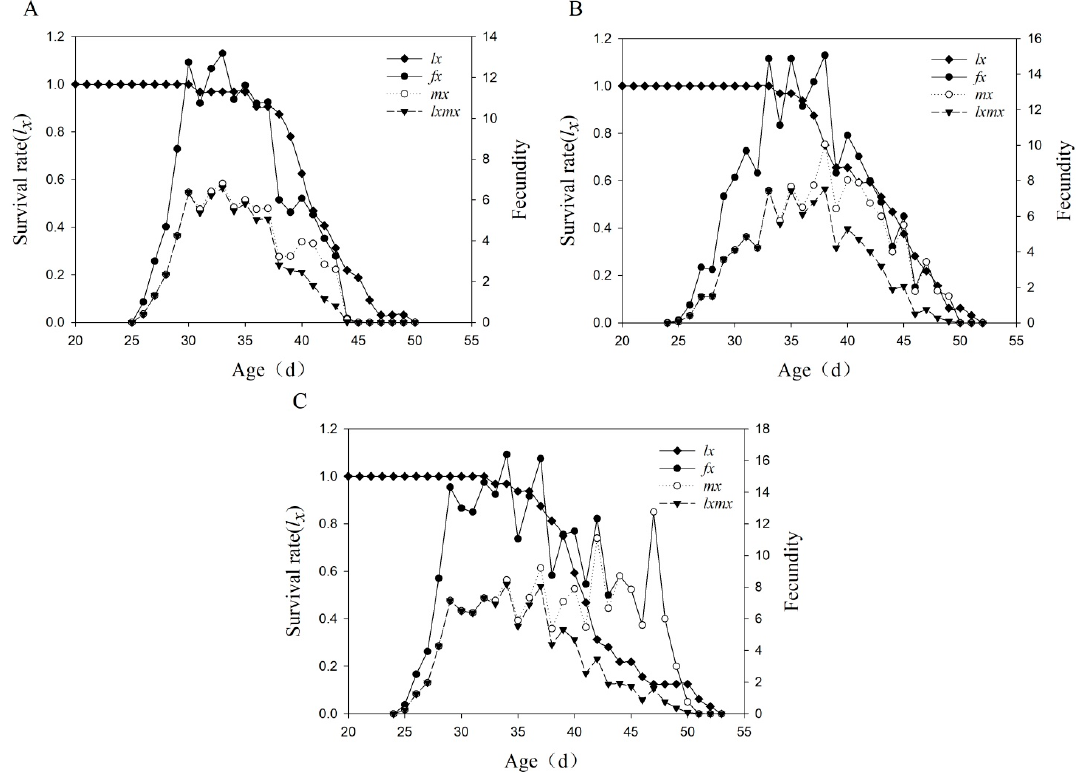
Figure 1. The age-specific survival rate ( l x ), female age-specific fecundity ( f x ), age-specific fecundity of total population ( m x ), and age-specific maternity ( l x m x ) of S. furcifera. ( A – C ) represent susceptible strain, F 19 and F 20 generations, respectively.